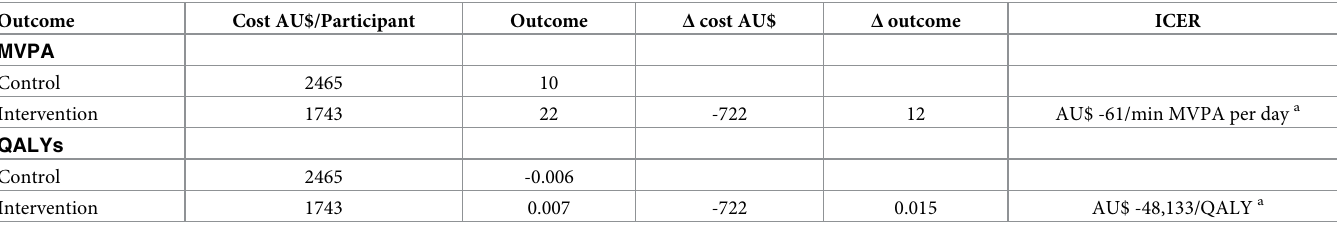
Table 3. Costs, changes in outcomes and incremental cost-effectiveness ratios at follow-up.